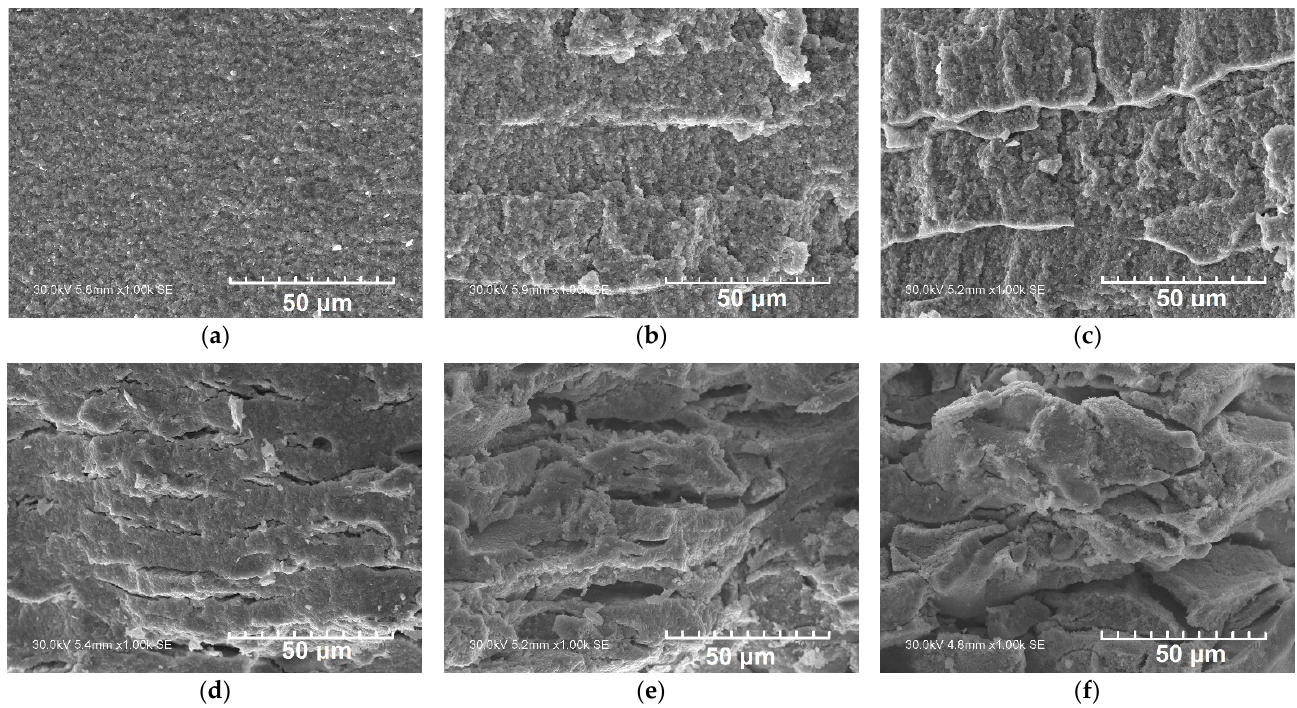
Figure 9. SEM images of cross sections of the NiO/YSZ anode after printing with layer-by-layer laser treatment at various laser exposure values and sintered at 1400 °C; without laser treatment ( a ), 4.5 ( b ), 5.9 ( c ), 7.8 ( d ), 10.6 ( e ), and 14.1 ( f ) J/cm 2 .